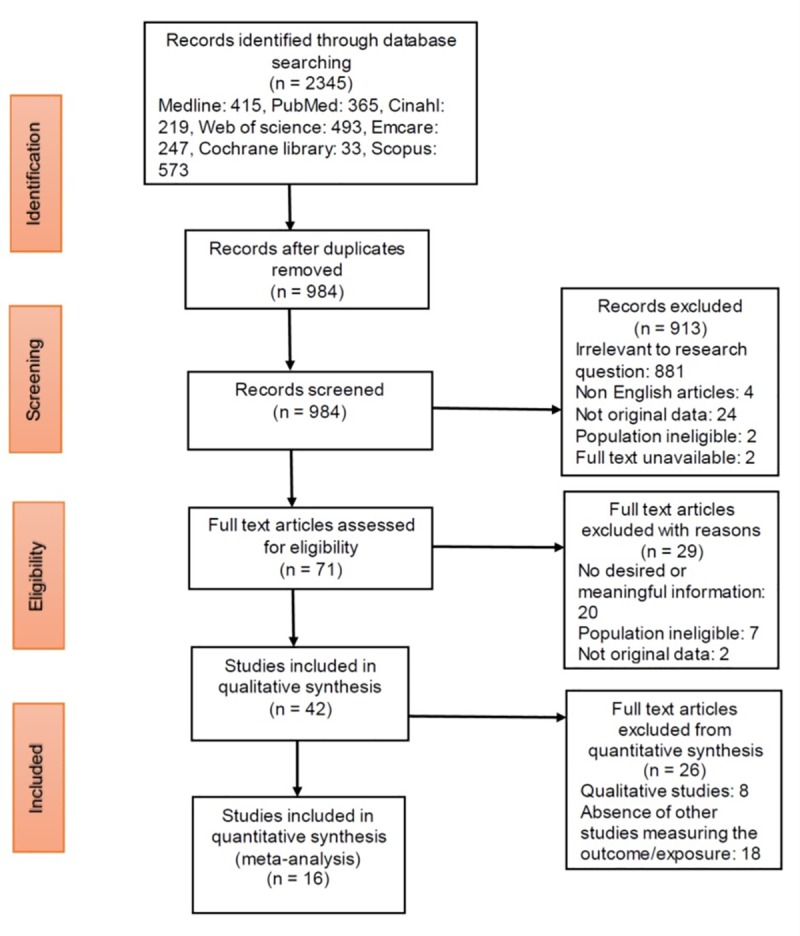
Study flow diagram.Study selection process and reasons for exclusion.